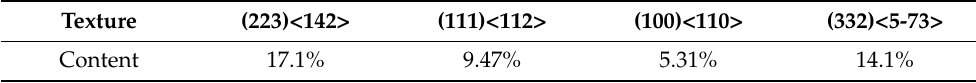
Figure 5. Characteristics of ferrite and carbide.( a ) Distribution of grain size, ( b ) Distribution of misorientation angle, ( c ) IPF map, ( d ) Carbide morphology, ( e ) Polefigure of (100) crystal plane, ( f ) ODF of φ = 45°. Table 2. Fraction of each texture.